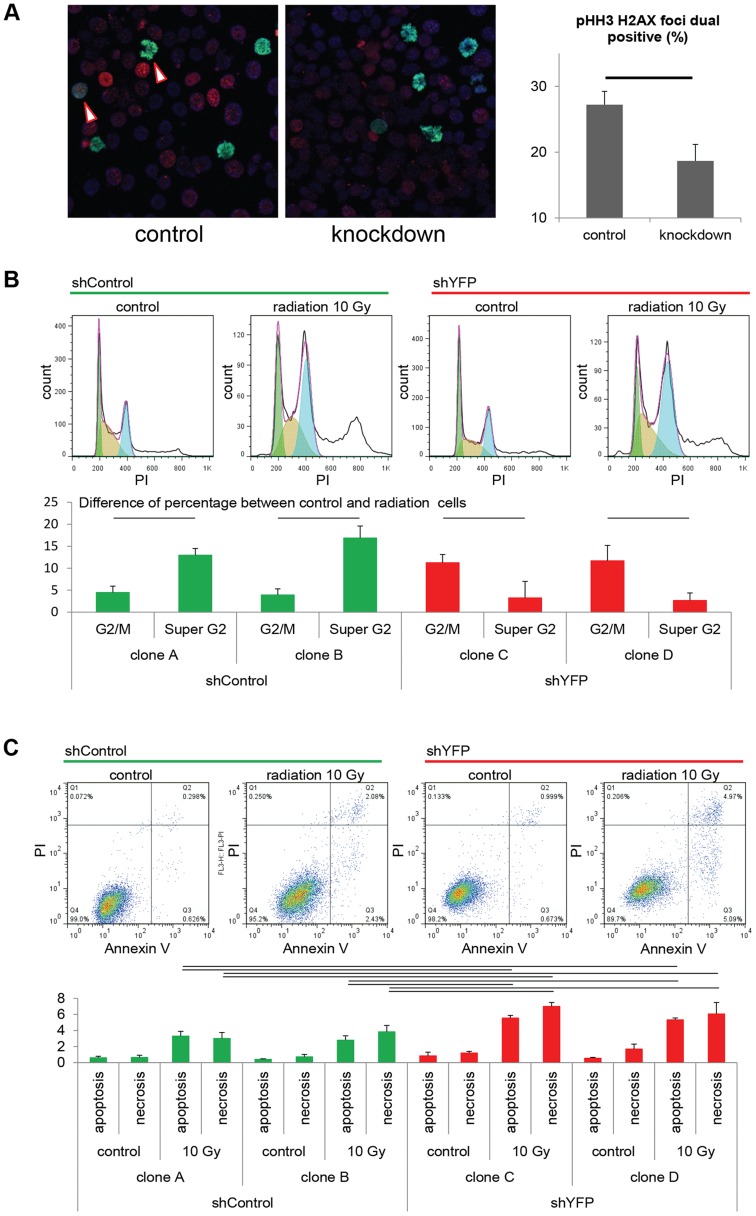
Pax3:Foxo1a facilitates G2/M checkpoint adaptation.(A) Immunocytochemistry for pHH3 (green), pH2AX (red) and DAPI (Blue) using U23674 mouse aRMS primary cell culture with or without Pax3:Foxo1a knockdown treated with 6 Gy irradiation. Black line shows significant difference (p<0.05). See Figure S2A for representative single-channel ICC images corresponding to Figure 5A. Arrowheads indicate pHH3 and pH2AX double positive cells. (B) Representative cell cycle analysis for U23674 transfected by shControl (Clone A) or shYFP (Clone C) with or without 10 Gy irradiation. The graph shows the differences of percentage between control and radiated cells in shControl and shYFP clones in 3 independent experiments. Black line shows significant difference (p<0.05). (C) Annexin V apoptosis detection assay for U23674 transfected by shControl or shYFP clones with or without 10 Gy irradiation. Black line shows significant difference (p<0.05).